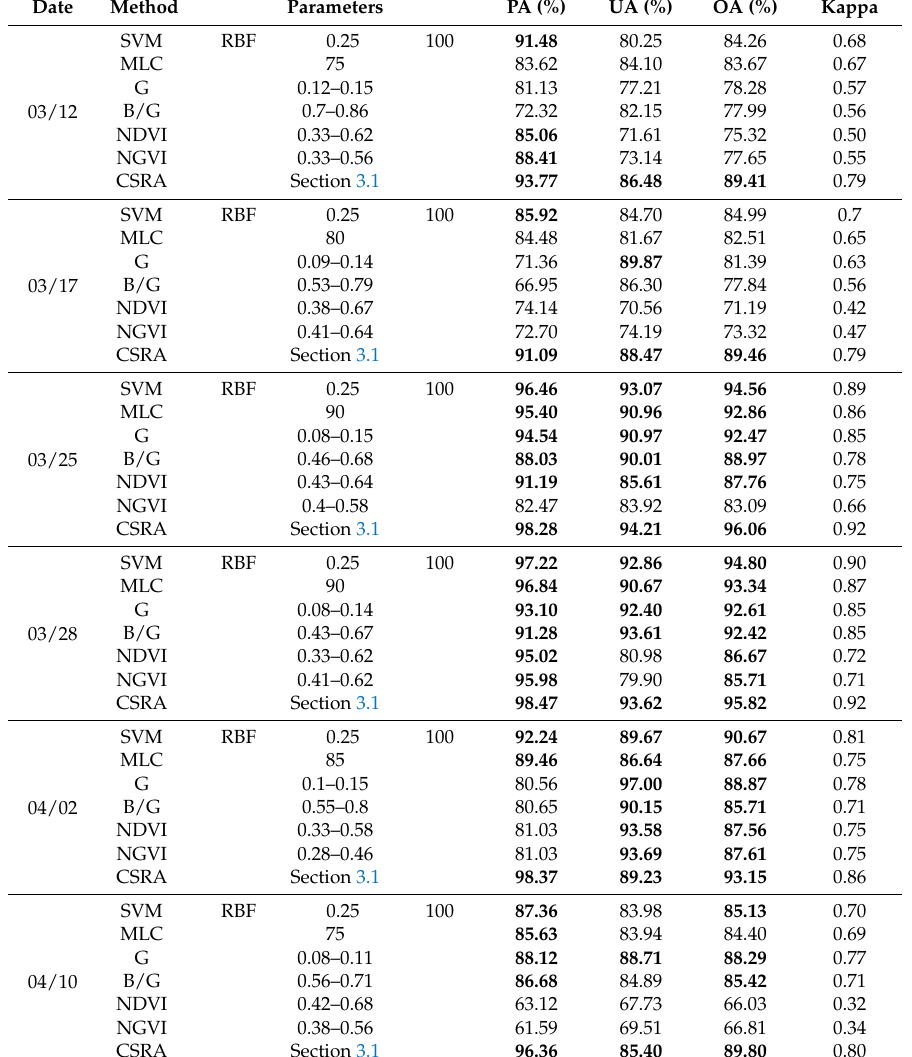
Table 7. Comparison of the accuracies of GF-1 WFV-derived oilseed rape maps in Wuxue City between the CSRA method and other previous